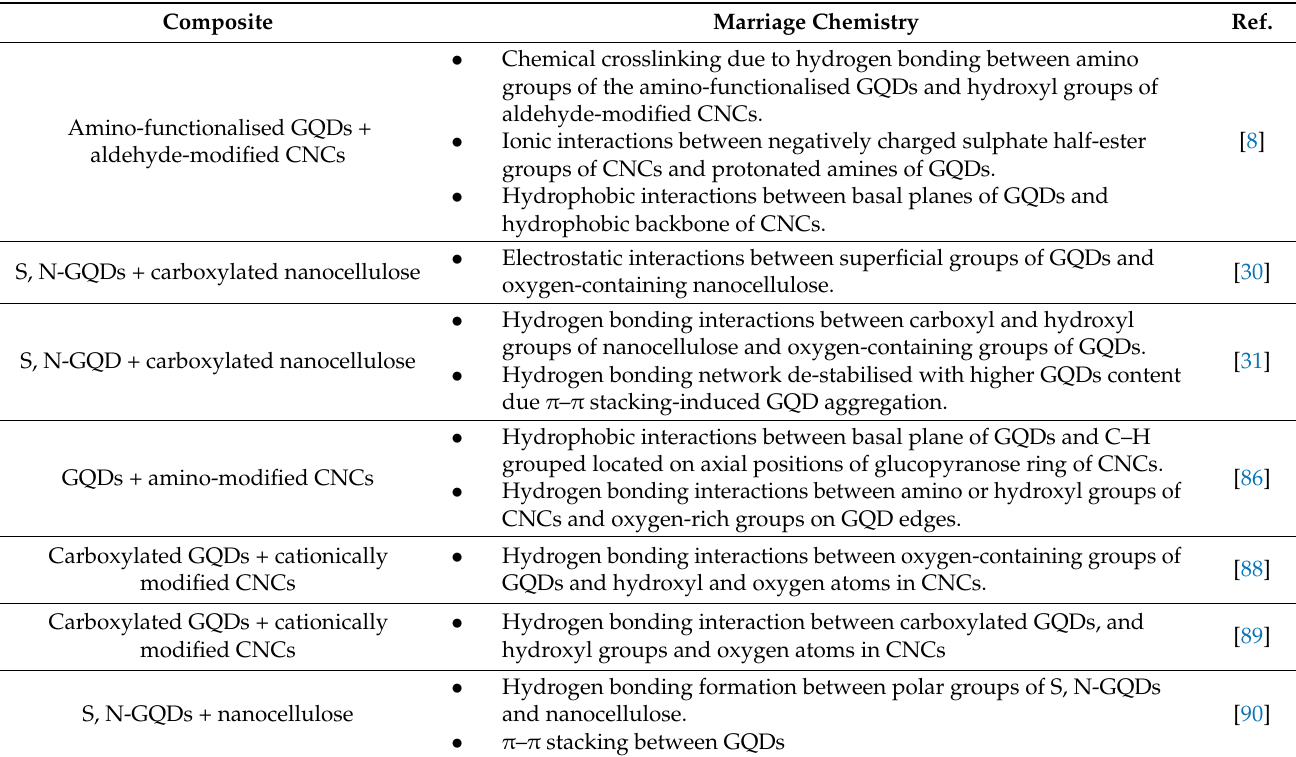
Table 1. A summary of marriage chemistry of GQDs–nanocellulose composites. Composite Marriage Chemistry Ref.